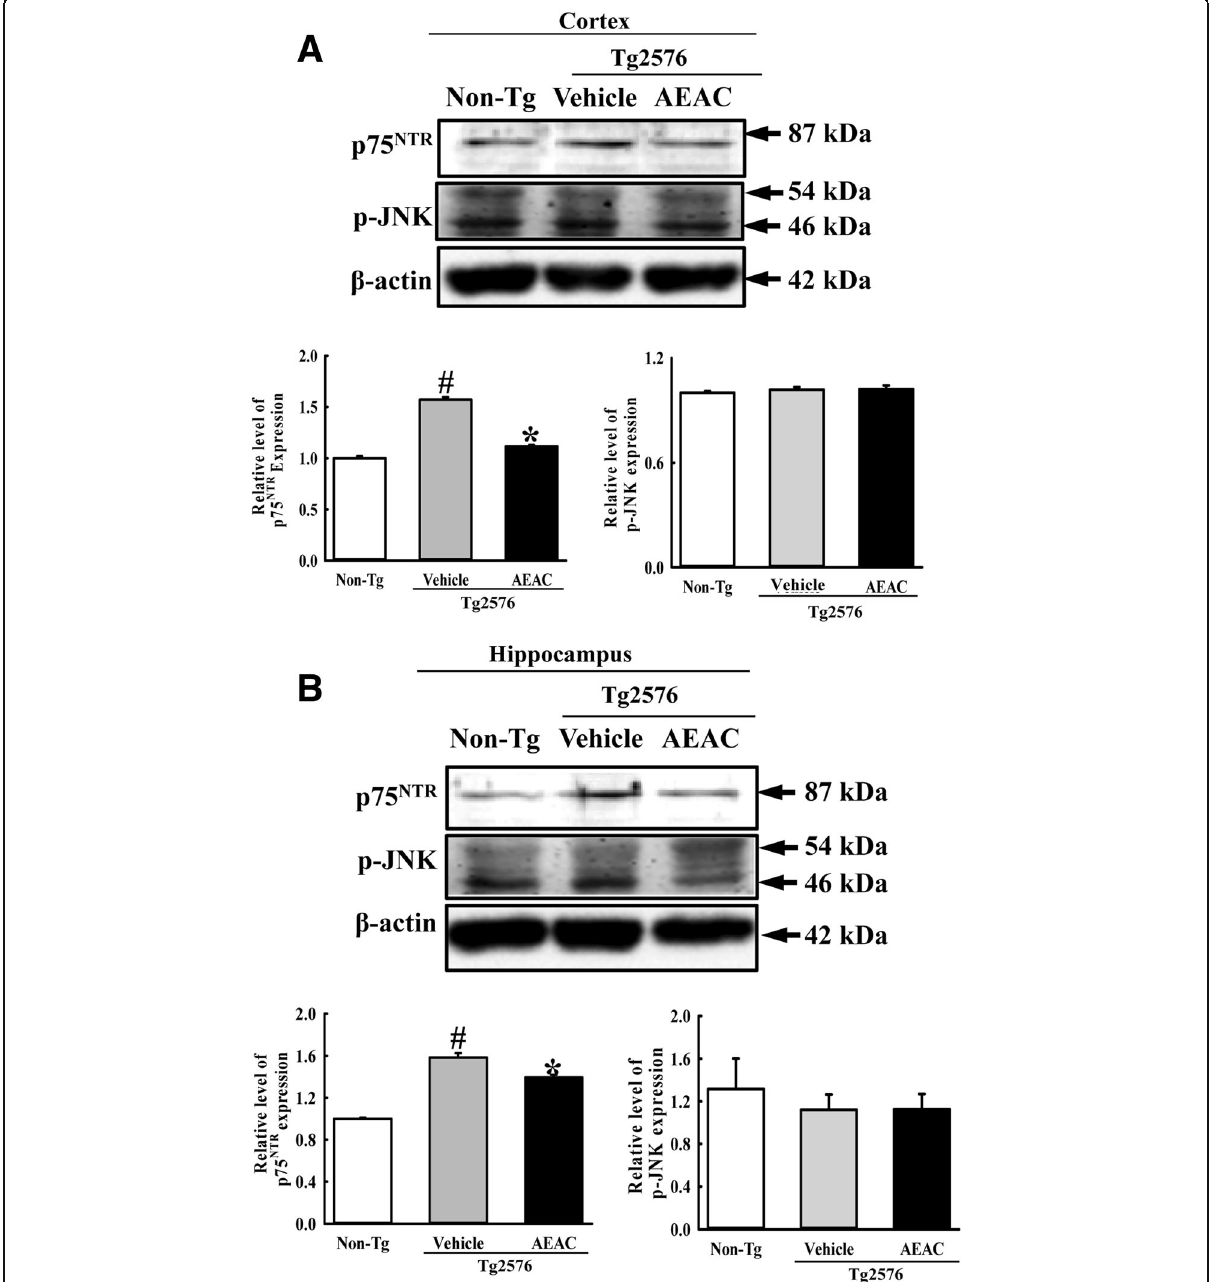
Fig. 5 Downstream signaling pathway of p75 NTR NGF receptor. Tissue lysates were prepared from the cortex a and hippocampus b of Tg2576 mice treated with vehicle or AEAC as described in the Methods. Fifty micrograms of protein per sample were immunoblotted with antibodies for each protein. Three samples were assayed in triplicate by Western blotting. Data are reported as the means ± SD. # , P < 0.05 compared to the Non-Tg group. *, p < 0.05 compared to the Vehicle treated Tg2576